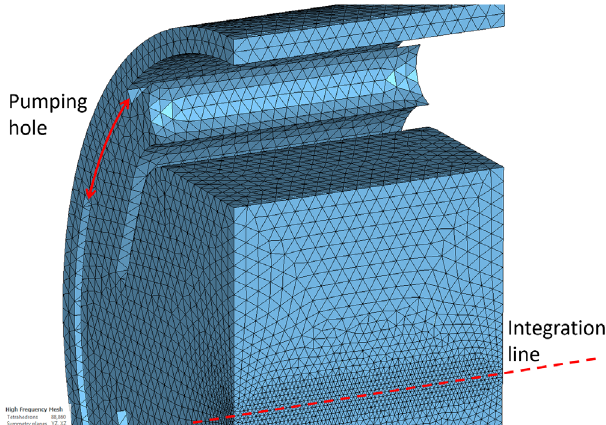
Þ are in x FIG. 8. Meshing of the vacuum volume in the FCC-hh beam screen used in the CST eigenmode simulations. To calculate very low impedances of the structure with the slit width of 7.5 mm, we used 88 860 noncurved tetrahedral mesh cells, a 1.1 mesh equilibrate ratio, the third-order solver, and two adaptive mesh refinement